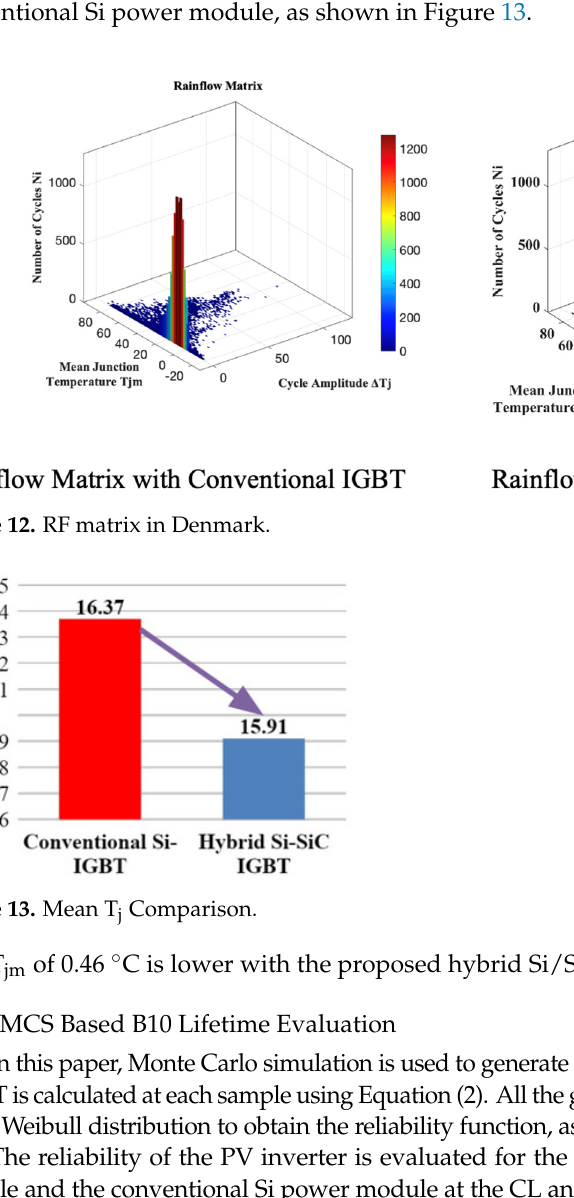
9 of 14 Figure 11. Yearly T j in Denmark.